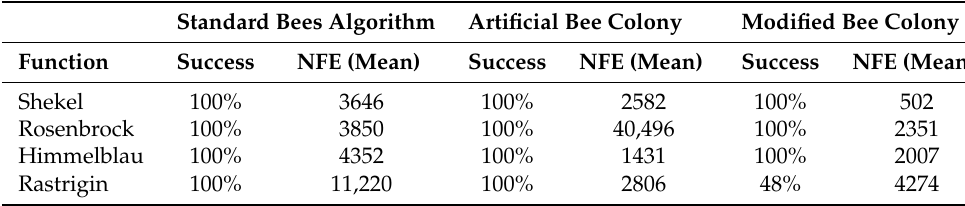
Table 5. Statistical comparison between SBA, ABC and MBC.